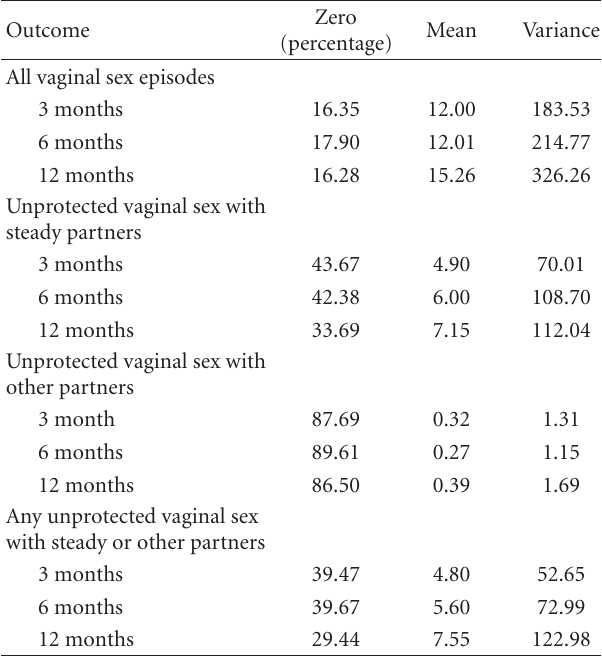
Table 1: Distribution of